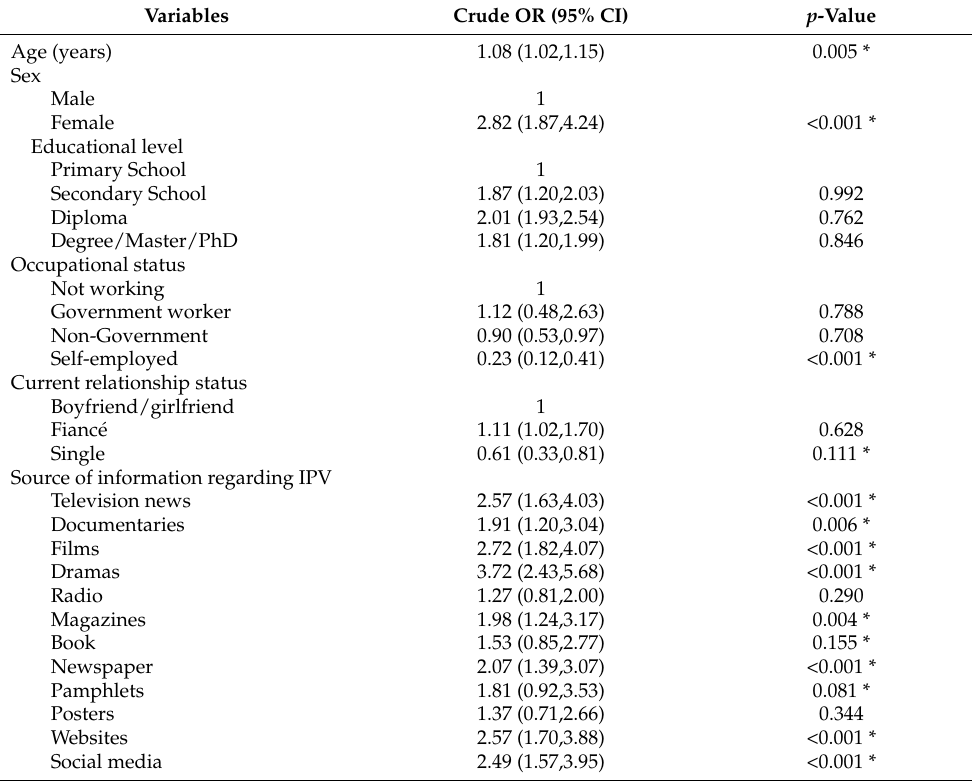
Table 3. Simple logistic regression of the association between factors and attitude towards rejecting IPV among premarital young adults in Kelantan (n = 405).